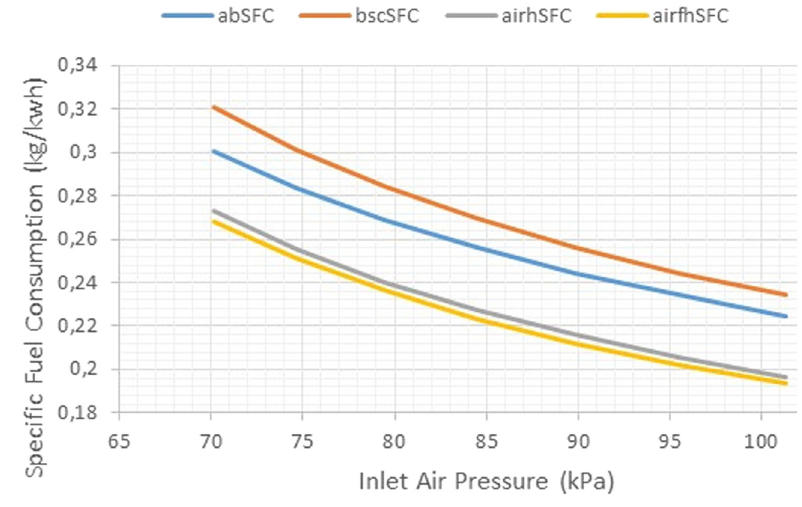
Figure 7: Variation of the SFC with inlet air ( atmospheric ) pressure for ab, bsc, airh, and airfh cogeneration systems.